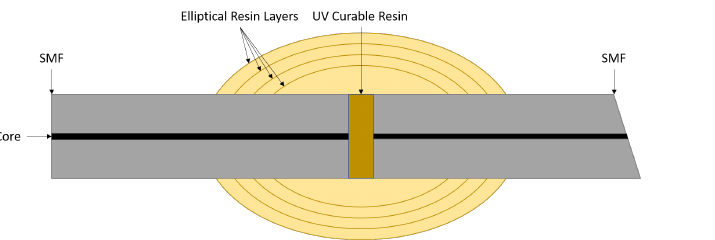
Figure 4. Schematic of an EFPI hydrostatic pressure sensor based on Oliveira et al. (Adapted with permission from ref. [19]. Copyright 2019 IEEE).